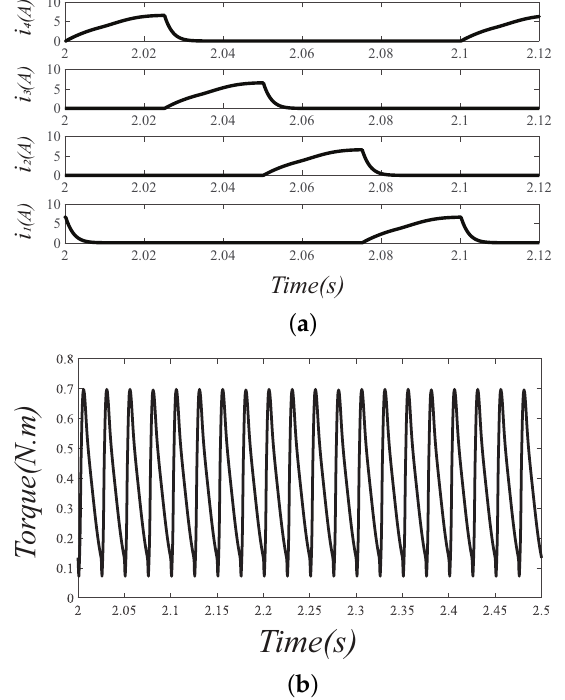
Figure 11. Simulation results (nine-bipole machine). ( a ) current, and ( b ) torque. Figure 12 presents torque densities for six high-torque electric motors available in the literature. The airgap-less electric motor (proposed by the authors) is also among these motors.